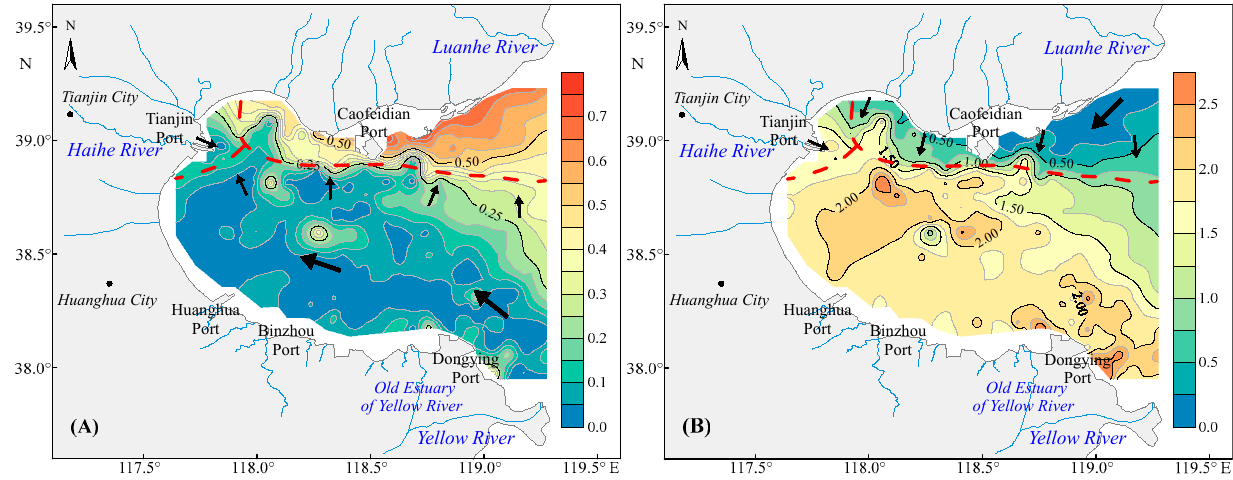
Figure 3. Contour map of DF in Bohai Bay based on Ca/Al. ( A ) DFYR: DF of surface sediments with Yellow River source. ( B ) DFLR: DF of surface sediments with Luanhe River source. Red dotted lines indicate the approximate range of influence of different river sources. Black arrows indicate the direction of sediment diffusion.